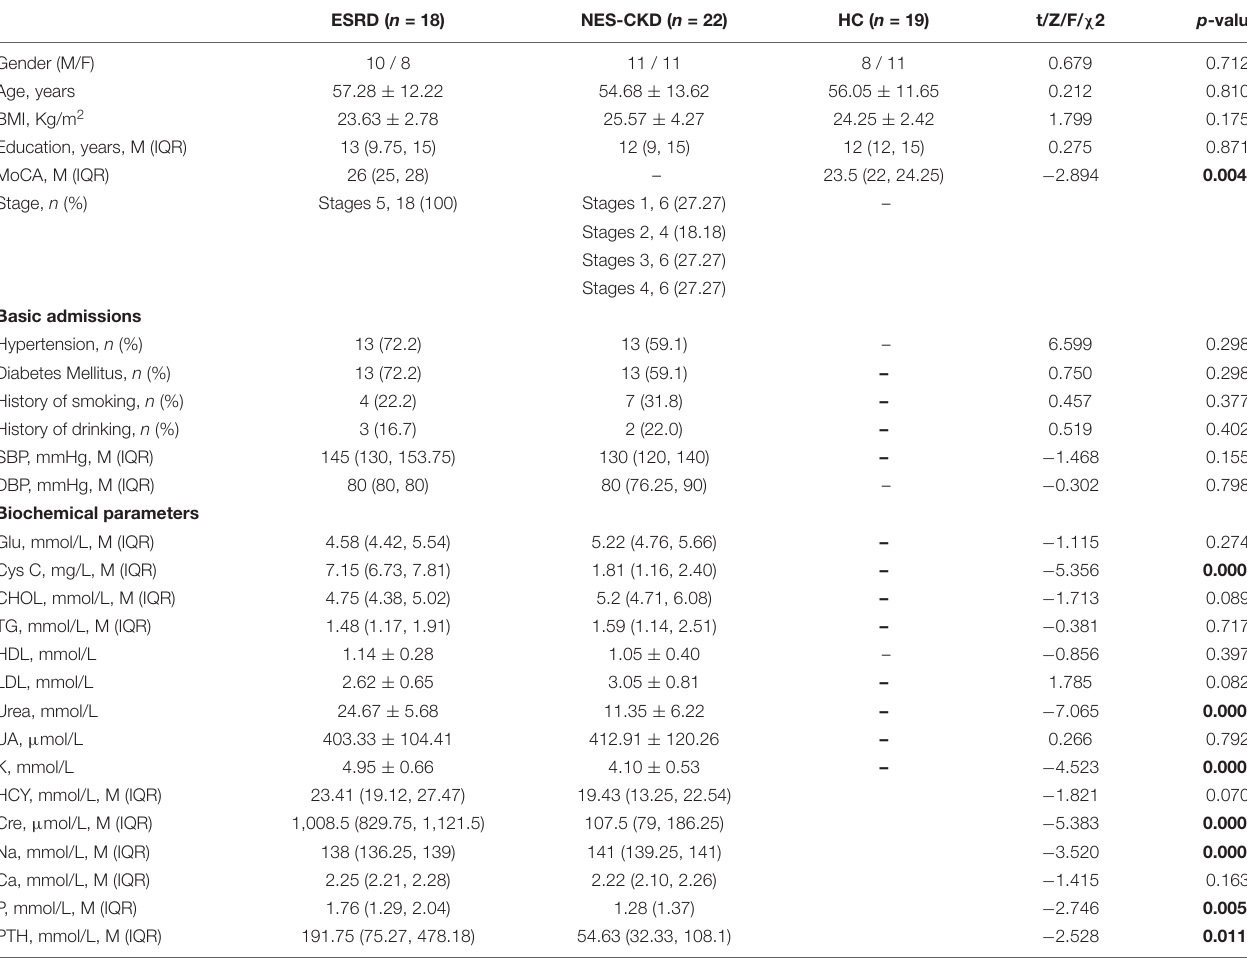
TABLE 1 | Demographic and clinical